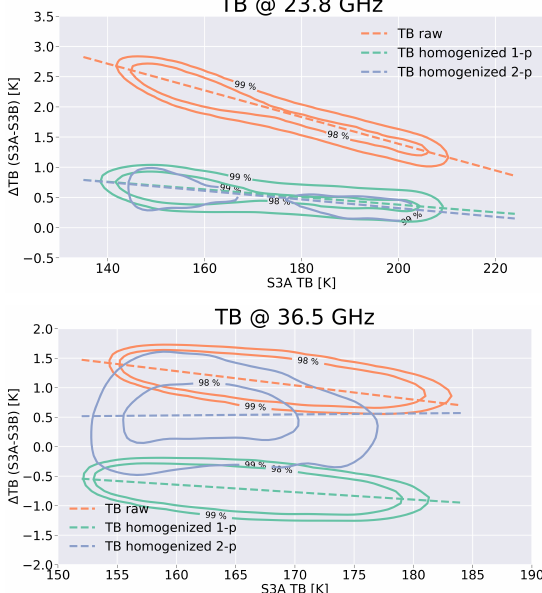
Figure 5. Density contour of the variation of the difference between S3-A and S3-B T B with S3-A T B . Orange contours refer to the baseline T B , the light green contours refer to the homogenized h-1p T B and the blue contours refer to the homogenized h-2p T B